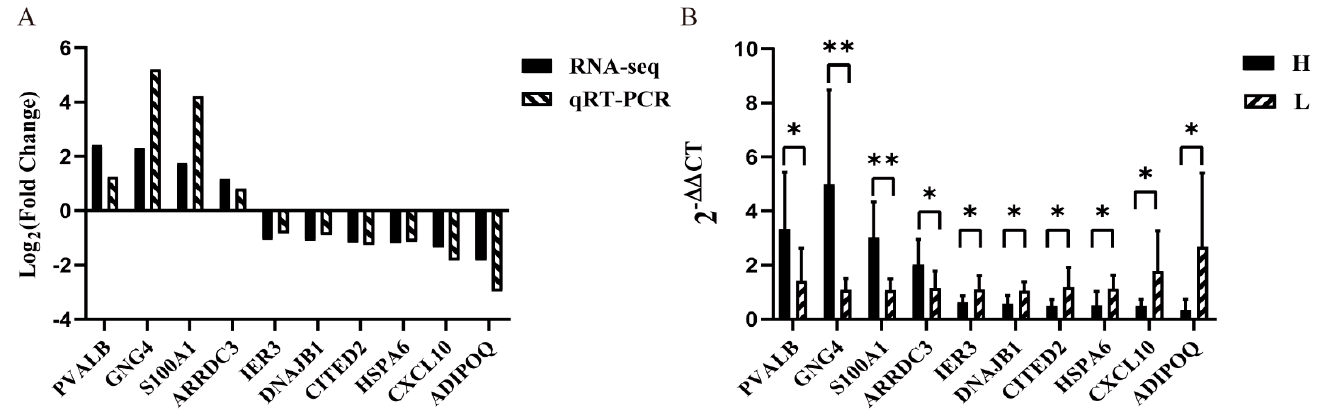
Figure 7. Comparison of gene expression. ( A ) Comparison of the fold change between RNA-seq and qRT-PCR. ( B ) Gene expression of H and L group by qPCR. * p < 0.05, ** p < 0.01.